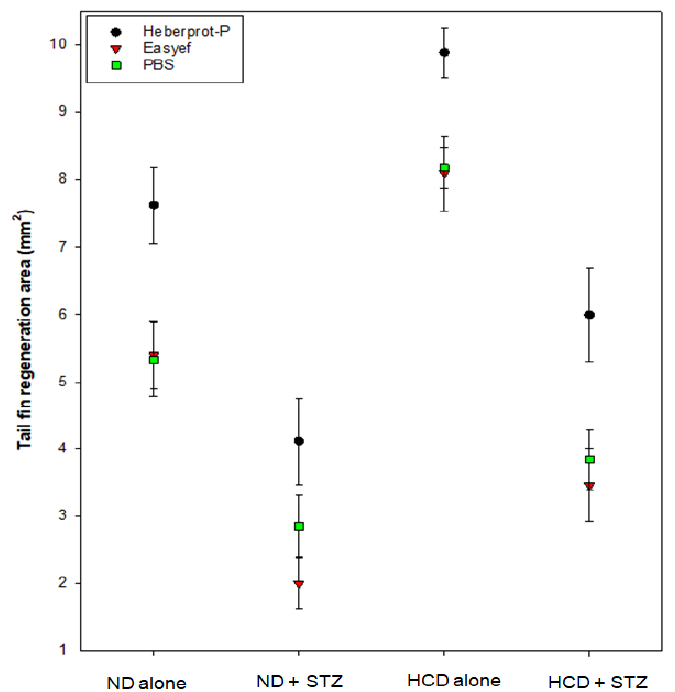
Figure 9. Tissue regeneration area at seven days post-injection depends on the diabetic condition induced by streptozotocin (STZ) injection and on hyperlipidemia by cholesterol feeding. ND, normal diet; HCD, high-cholesterol diet.